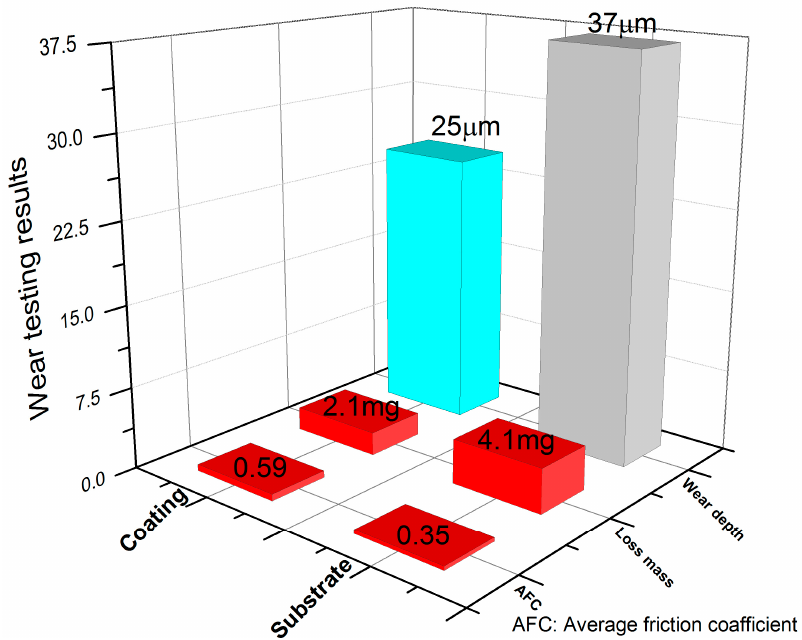
Figure 10. Wear testing results of the coating and the substrate.